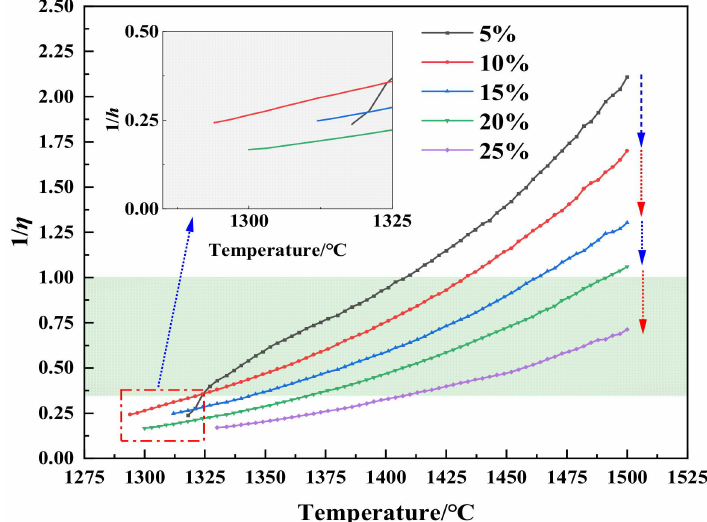
Figure 3. Curve of the fluidity of modified blast furnace slag as a function of temperature.